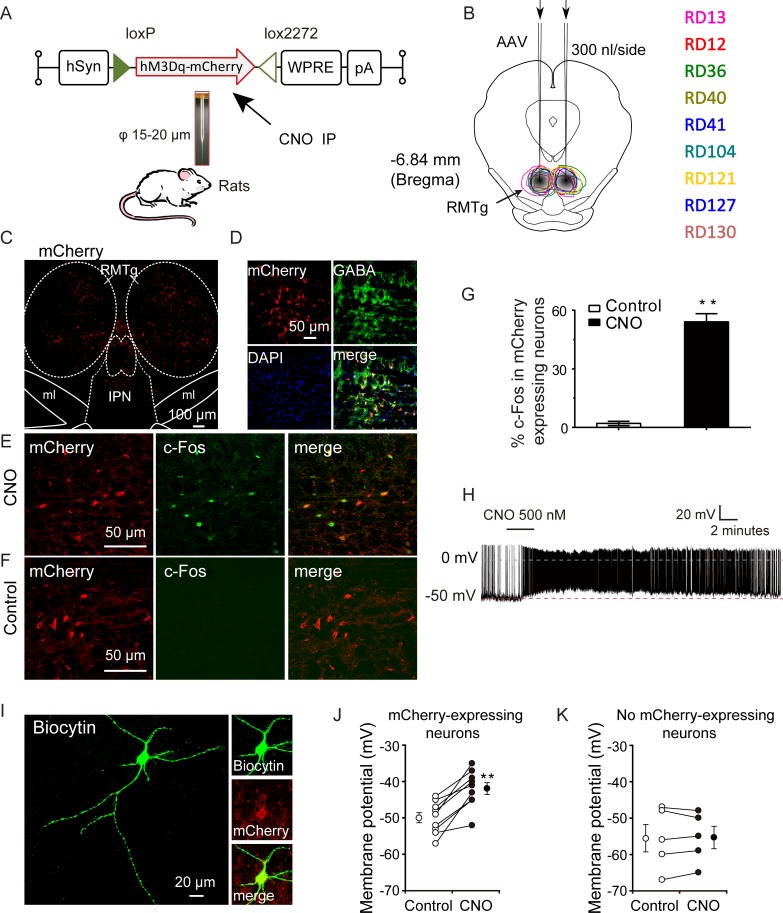
Pharmacogenetic activation of the hM3Dq-expressing rat rostromedial tegmental nucleus (RMTg) neurons.Schematic representation of the Cre-independent adeno-associated virus (AAV) vectors expressing hM3Dq receptors under the control of hSyn promoter. hSyn, human synapsin promoter; WPRE, woodchuck hepatitis virus post-transcriptional regulatory element; CNO, clozapine-N-oxide; IP, intraperitoneal. (B) The coronal section shows the superimposed virus-injected area in 9 rats numbered with the same color characters as the closed curves. The bilateral shaded areas indicate the rat RMTg locations. (C) mCherry immunolabeling (red) indicates hM3Dq-expressing neurons of the RMTg. IPN, interpeduncular nucleus; ml, medial lemniscus. (D) Representative photomicrographs of the RMTg depicting mCherry expression (red), γ-amino butyric acid (GABA) immunoreactivity (green), 4,6-diamidino-2-phenylindole (DAPI, blue), and merge (yellow) images from a rat microinjected with Cre-independent AAV vectors containing hM3Dq. (E, F) CNO (E), not saline (F), drives c-Fos expression in hM3Dq-expressing neurons in the RMTg. (G) Quantification of c-Fos staining in mCherry-expressing RMTg neurons after saline or CNO injection in rats. **p < 0.01 versus saline by unpaired t tests (n = 3, per group). (H) A typical example of voltage trace recorded from an hM3Dq+ rat RMTg neuron during application of CNO in a brain slice. CNO application (horizontal bar) increased the action potential firing. (I) Merged image of mCherry and biocytin showing a fluorescent view of the patched cell. Left panel: biocytin-labeled neuron; right panel: cell with green (biocytin; top), red (hM3Dq-mCherry; middle), and yellow (merged; bottom) fluorescence. (J, K) Average membrane potential of RMTg hM3Dq+ neurons (J, n = 7 cells), but not hM3Dq− neurons (K, n = 5 cells), was significantly increased by CNO application. The results from each cell are shown on the scatterplot. **p < 0.01 versus saline by paired t tests. Underlying data can be found in S1 Data.